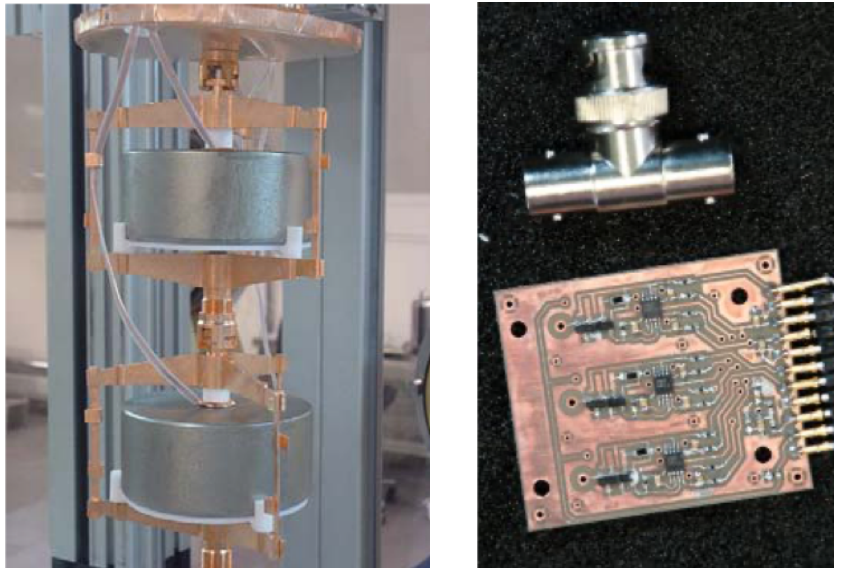
Figure 6. Two BEG E detectors embedded in a string in their Cu holder ( left ), and one low-activity, cold, front-end circuit serving three detectors ( right